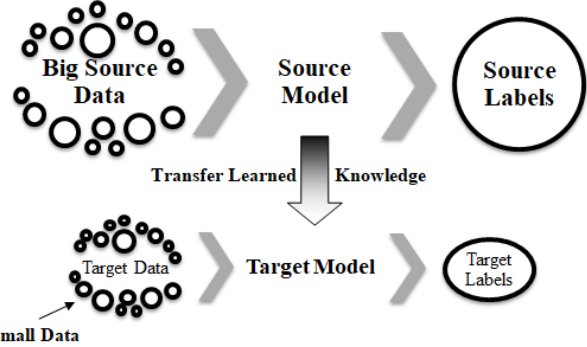
Figure 6. Transfer Learning